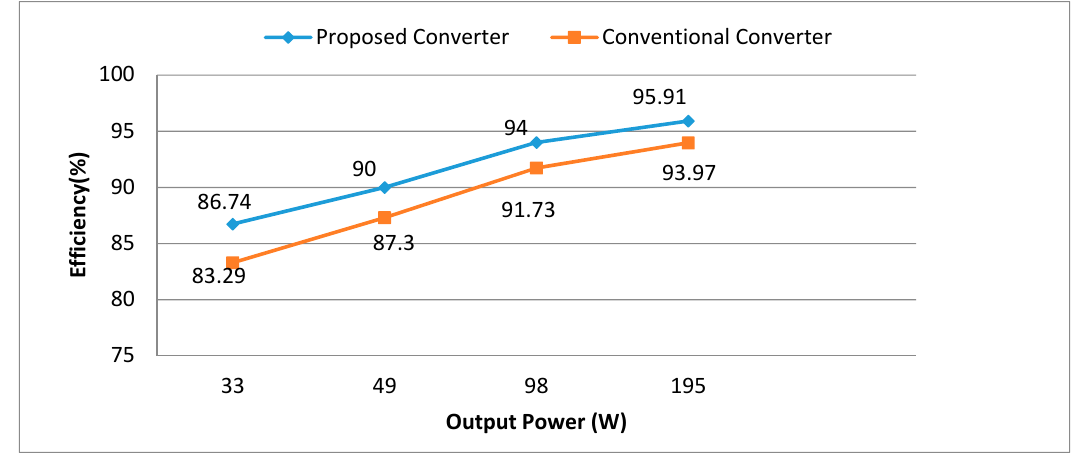
Figure 11. Efficiency graph. Figure 11. E ffi ciency